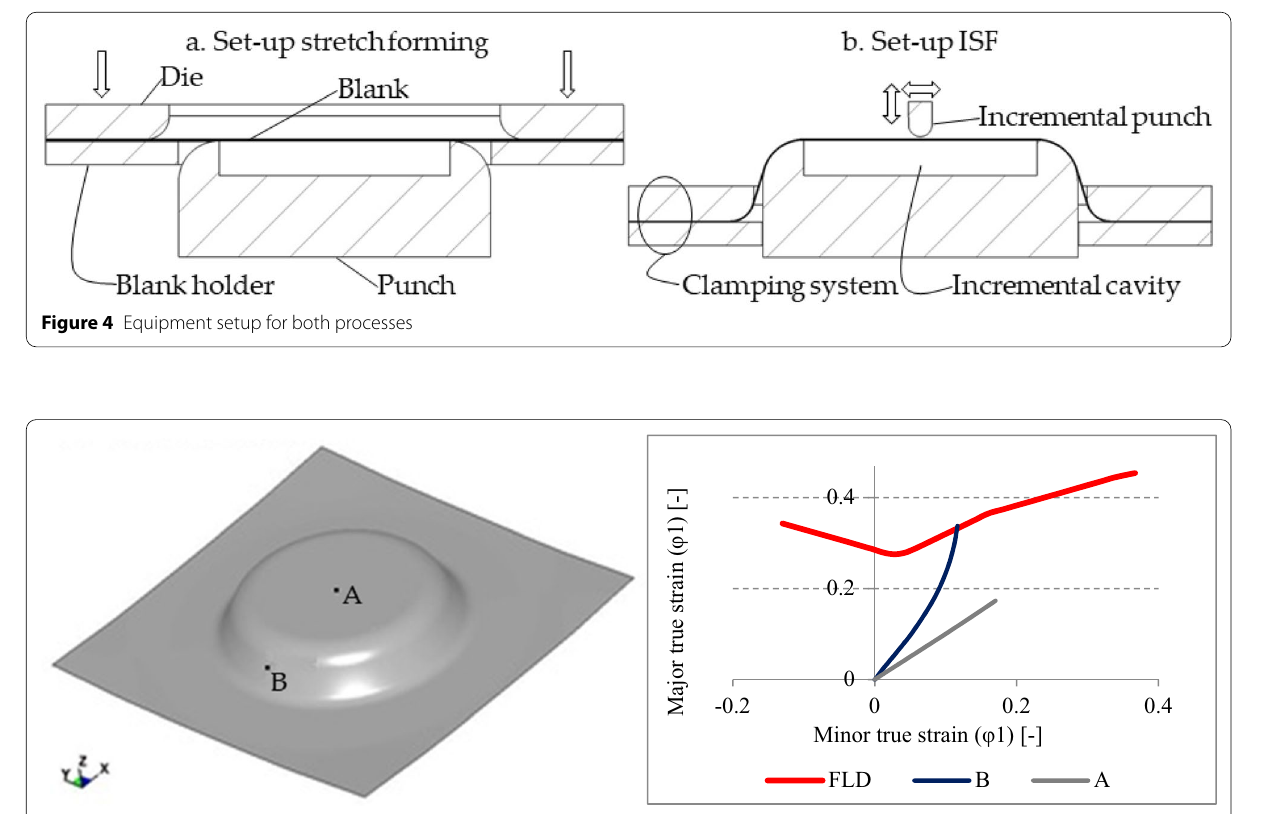
Figure 5 Forming paths for different elements of a formed sample. FLD from work